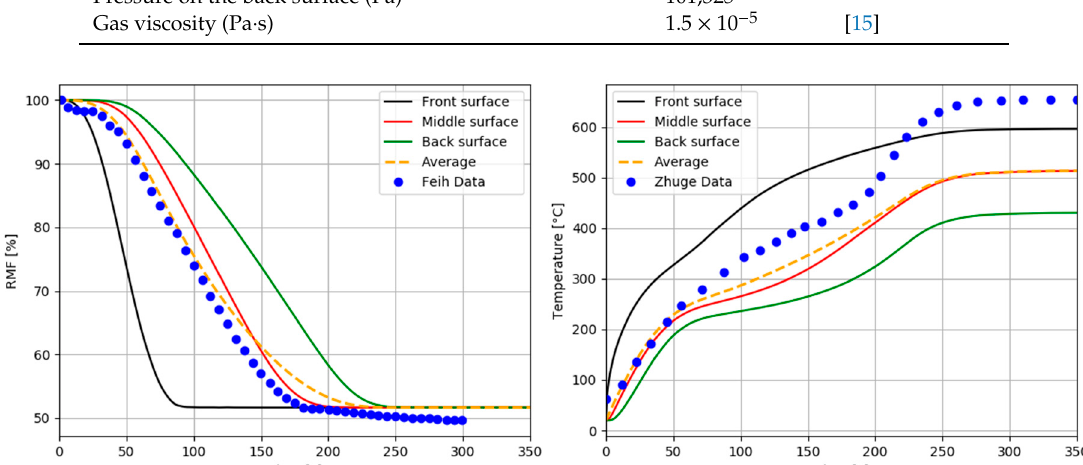
Figure 6. Remaining mass fraction (RMF) profiles and temperature profiles. Comparison between our numerical simulation prediction as a function of time and the experimental data of Zhuge et al. [25] for an E-glass/ polyester composite laminate at a heat flux of 50 kW/m 2 .